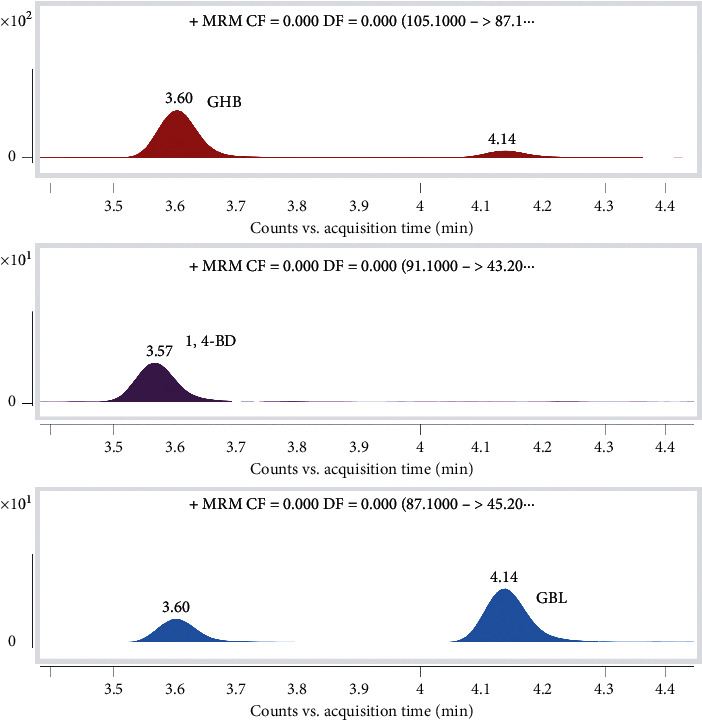
The chromatographic separation results obtained for GBL, GHB, and 1,4-BD are as follows: RtGHB = 3.60 min, Rt1,4-BD = 3.57 min, and RtGBL = 4.14 min.